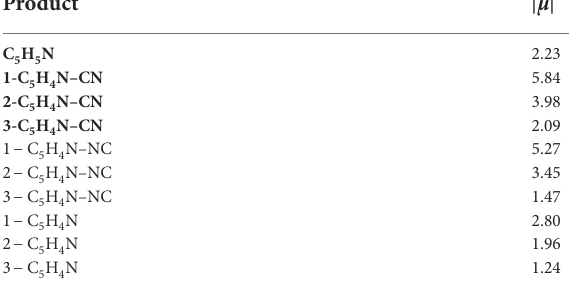
TABLE 6 Magnitude of the dipole moments ( | μ | , in D) of the products for the reaction studied in this work and pure pyridine at the M06-2X-D3/def2-TZVP level of theory. In bold font, the main products of the